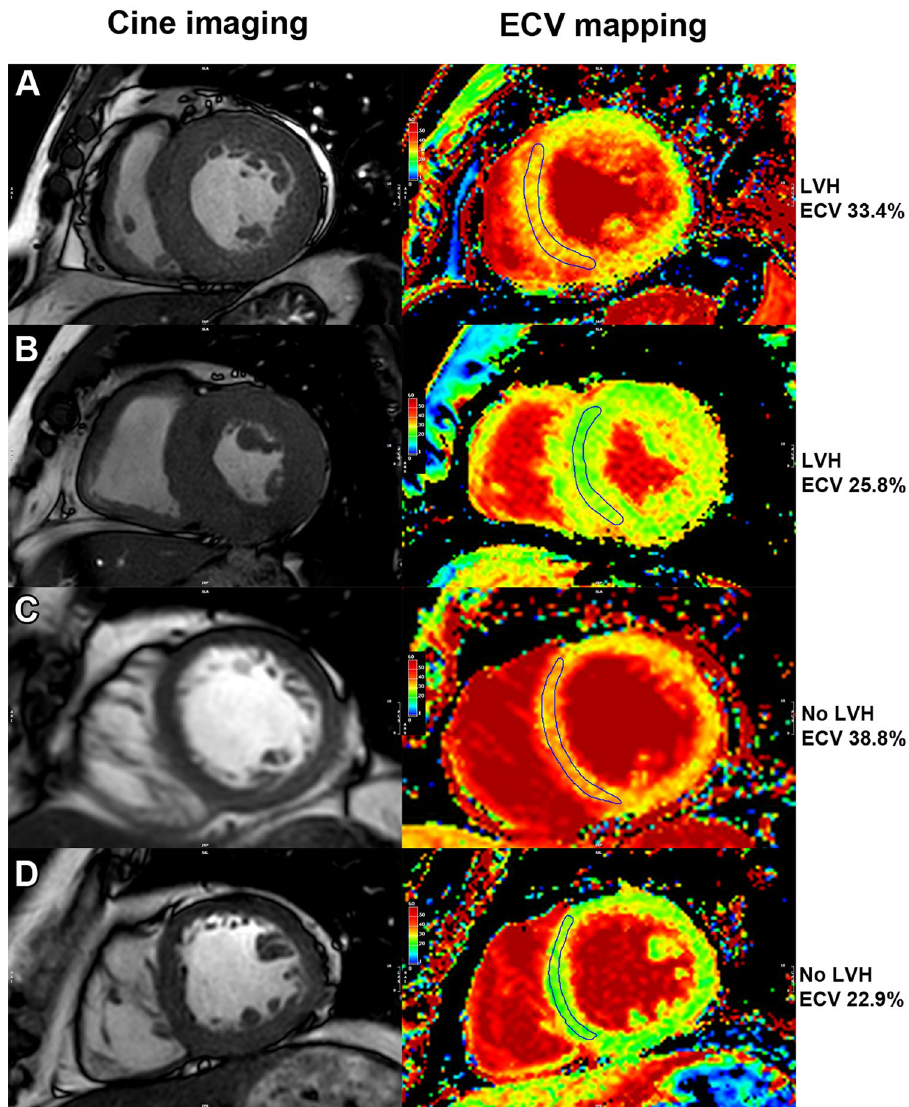
Figure 3. Cine images (left) and extracellular volume (ECV) mapping (right) of patients who had left ventricular hypertrophy (LVH) and high ECV ( A ), LVH and lower ECV ( B ), high ECV without LVH ( C ), and lower ECV without LVH ( D